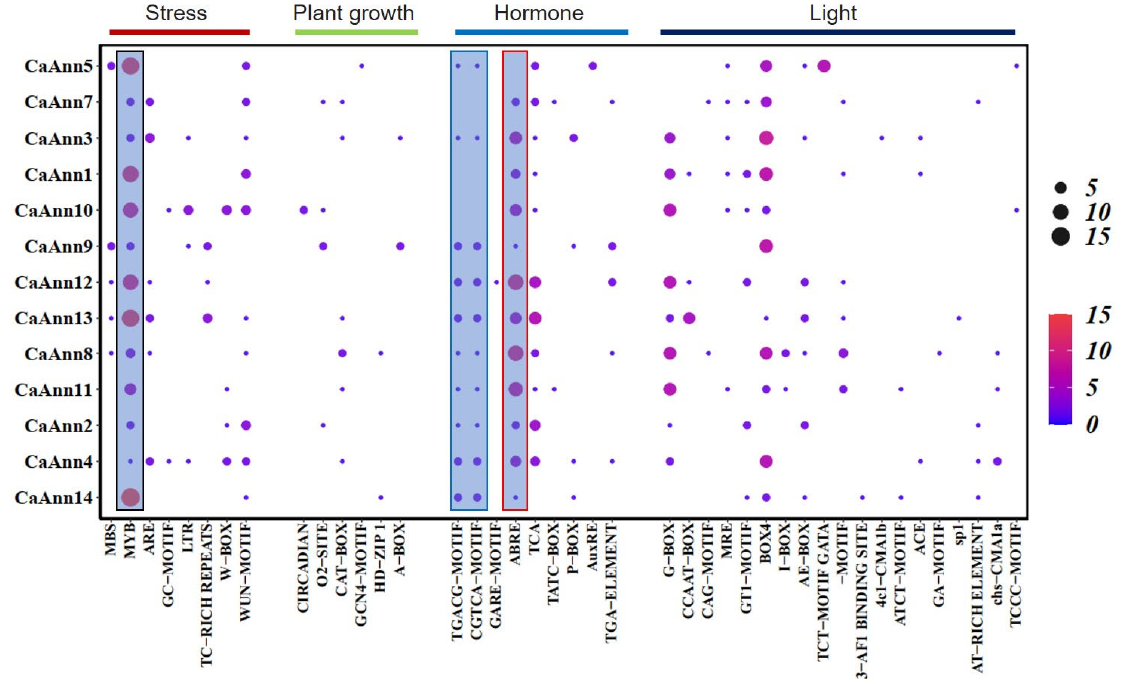
Figure 4. The heat map of cis ‐ element in CaAnn promoter regions. The color bar and circle size indicate the number of cis ‐ elements. The black box represents MYB element, the blue box represents MeJA ‐ responsive, and the red box represents ABA responsive module.